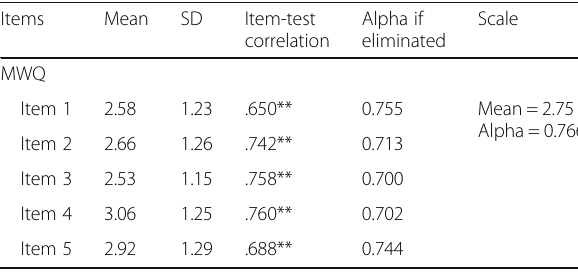
Table 2 The internal consistency of the MWQ